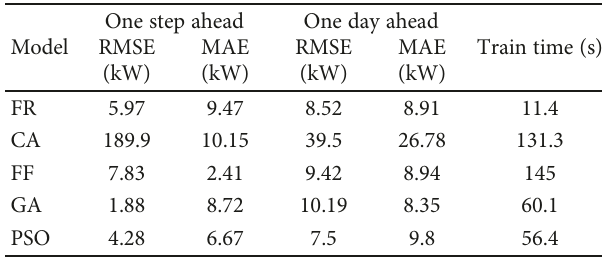
Table 1: Comparison of prediction interval forecast for wind